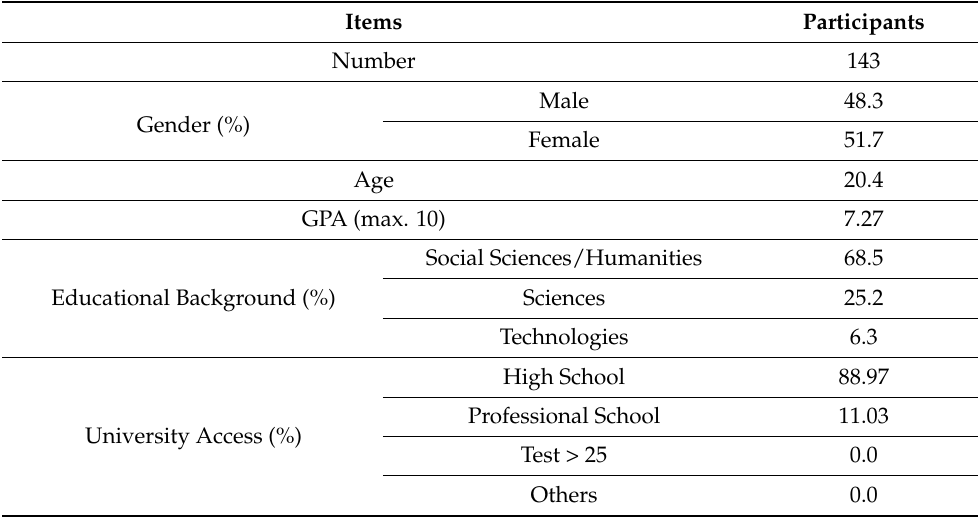
Table 1. Participants’ demographic information for the research